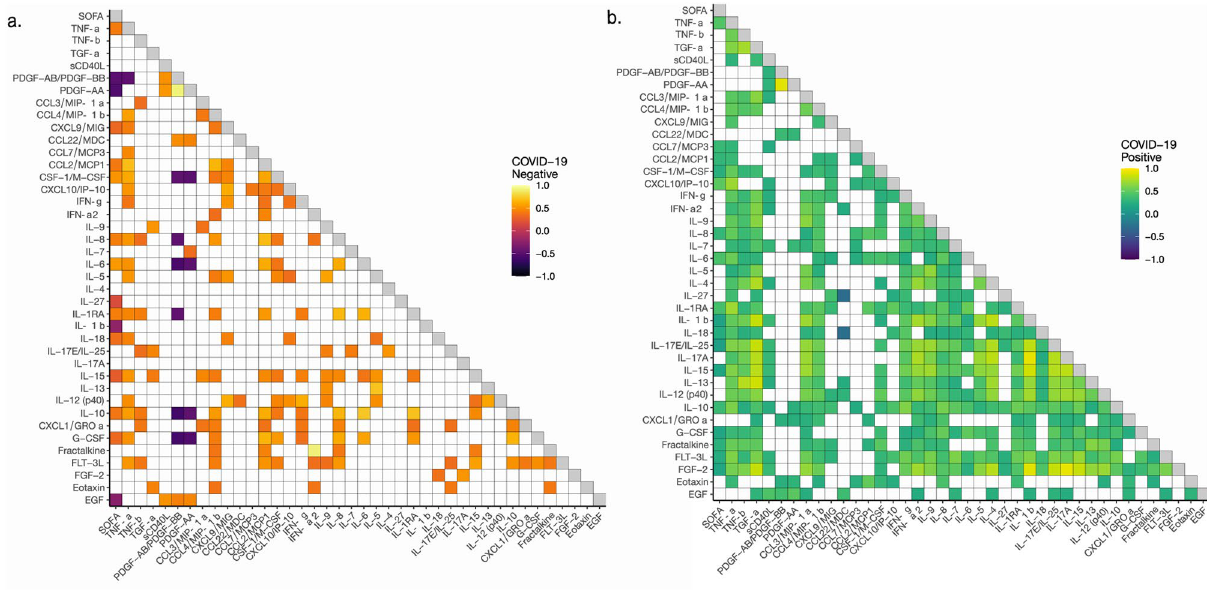
Figure 4. Cytokine and SOFA score correlations between positive and negative COVID-19 patients. Correlation matrix of 39 cytokines from patient serum comparing cytokine concentrations at day 1 of hospital admission with SOFA scores. Correlation heatmaps are stratified by COVID-19 patients and controls. Only significant correlations (p < 0.05) after adjustment for multiple comparisons are presented with a Spearman’s correlation coefficient value. The Spearman’s correlation coefficient is visualized by color intensity. SOFA Sequential Organ Failure